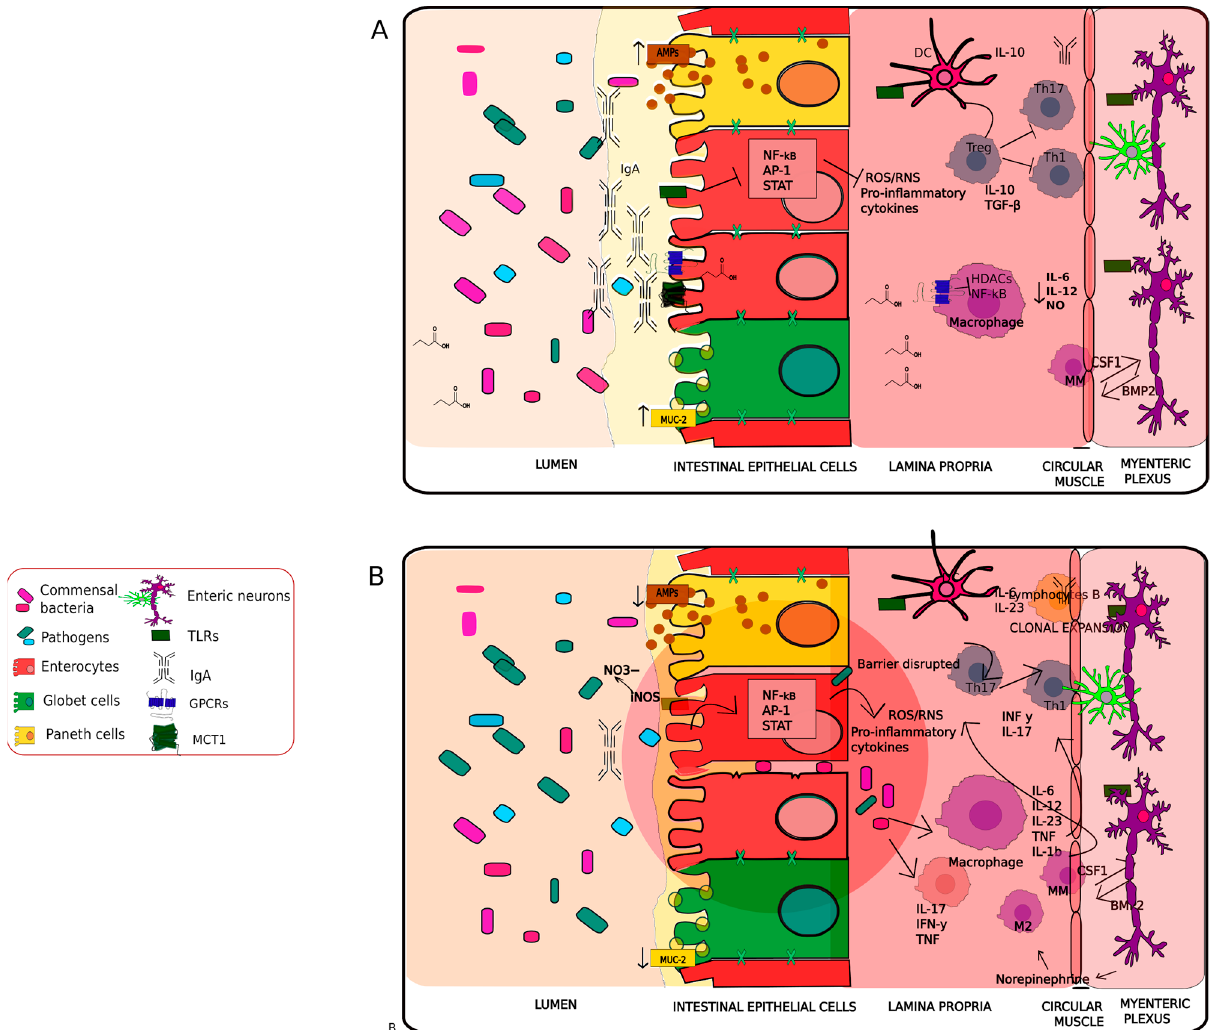
Figure 2. Neuronal and immunity crosstalk. ( A ) Under homeostasis, macrophages mature within the intestinal mucosa, where they are utilized to capture invading pathogens, recognize antigens, and clear old apoptotic cells within the area. Macrophages then transfer the captured antigens to the dendritic cells, which are responsible for entering the mesenteric lymph nodes to induce the differentiation of peripheral T regulatory (Treg) cells from naïve T cells[161]. These cells constitutively produce IL-10, which promotes the secondary expansion of regulatory T cells in the mucosa and maintains the homeostasis [161,162]. Butyrate is important in the modulation of intestinal macrophages via the inhibition of histone deacetylases and NF-kB, and thus downregulates proinflammatory responses such as IL-6, IL-12 and NO [163,164]. On the other hand, neuron enteric cells are essential for gastrointestinal motility. The Toll-like receptors (TLRs) expressed by enteric neurons can recognize gut microbe-derived signals and influence the gut motility[165]. These cells promote crosstalk with the Muscularis Macrophages (MMs) in longitudinal and circular smooth muscles and incite the production of the growth factor bone morphogenetic protein 2 (BMP2) to stimulate motility that is directed by the neurons. In turn, the